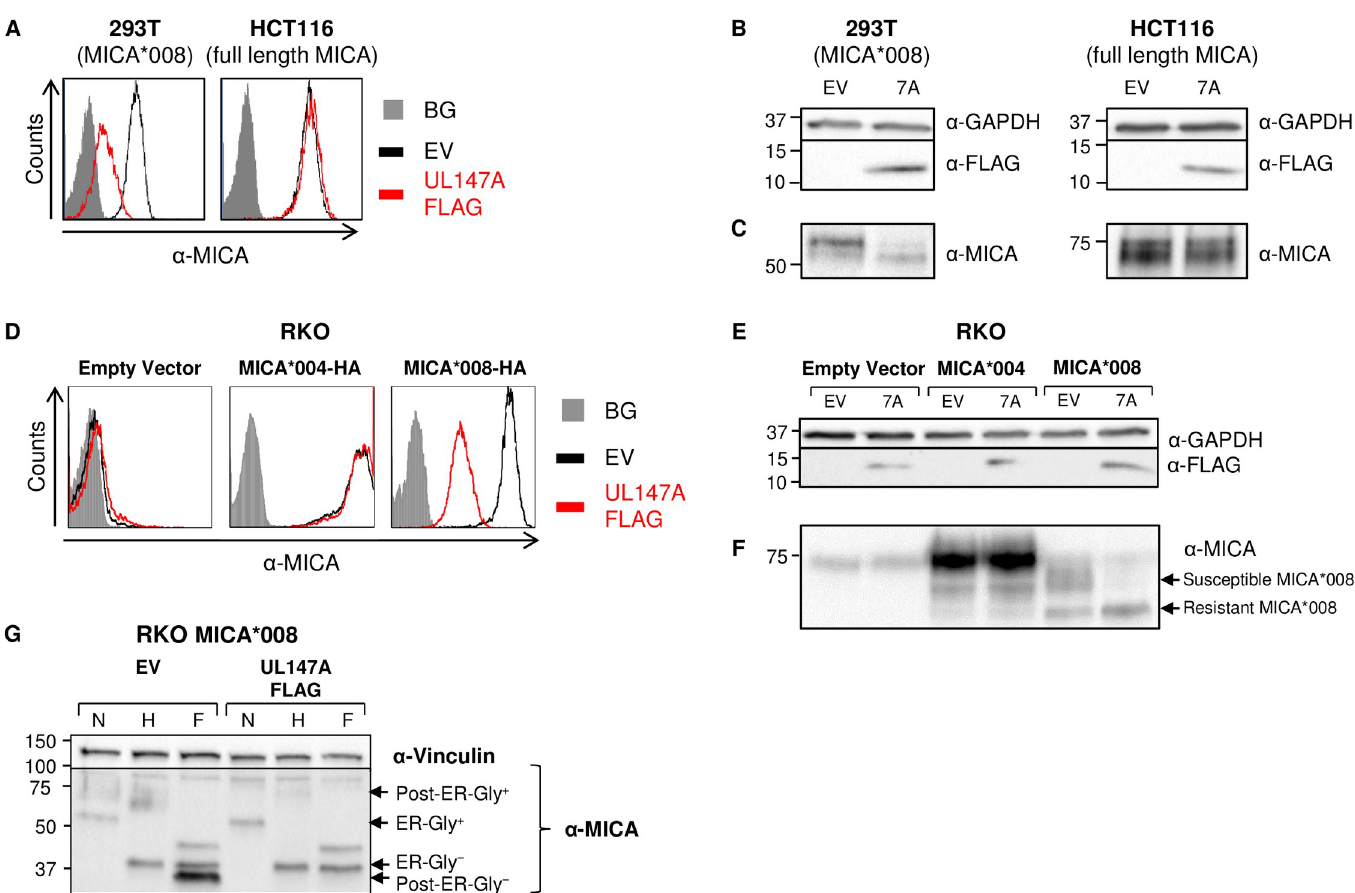
Fig 2. Total MICA � 008 protein quantity is reduced by UL147A overexpression. (A) 293T (MICA � 008 homozygous) and HCT116 (MICA � 001/ � 009:02 full length alleles) were transduced with an EV (black histograms) or with UL147A-FLAG (red histograms) and MICA surface expression was assayed by flow cytometry. Gray-filled histograms represent secondary antibody staining of EV cells, all control stainings were similar to the one shown. Representative of three independent experiments. (B-C) The cells shown in (A) were lysed and a western blot was performed using anti-MICA antibody for detection of MICA, anti-FLAG tag antibody for detection of UL147A, and anti-GAPDH antibody as a loading control. The lysates were split in two and run on two gels (shown separately in B, C) to resolve proteins of different sizes. Representative of three independent experiments. (D) RKO cells were transduced with an EV, with MICA � 004-HA or with MICA � 008-HA, and then co-transduced with an EV or with UL147A-FLAG. MICA surface expression was assayed by flow cytometry. Gray-filled histograms represent secondary antibody staining of EV cells, all control stainings were similar to the one shown. Representative of three independent experiments. (E-F) The cells shown in (D) were lysed and a western blot was performed using anti-MICA antibody for detection of MICA, anti-FLAG tag antibody for detection of UL147A, and anti-GAPDH antibody as a loading control. The lysates were split in two and run on two gels (shown separately in E, F) to resolve proteins of different sizes. Arrows indicate UL147A-susceptible and UL147A-resistant forms of MICA � 008. Representative of three independent experiments. (G) RKO MICA � 008-HA cells co-transduced with EV or UL147A-FLAG were lysed. Lysates were left untreated or digested with endoH or with PNGaseF (marked N, H and F, respectively), and then blotted using anti-MICA and anti-vinculin as a loading control. Arrows indicate ER-resident (endoH sensitive) and post-ER (endoH resistant) MICA � 008 forms, with and without glycosylations (Gly +/ − ). Representative of two independent experiments.